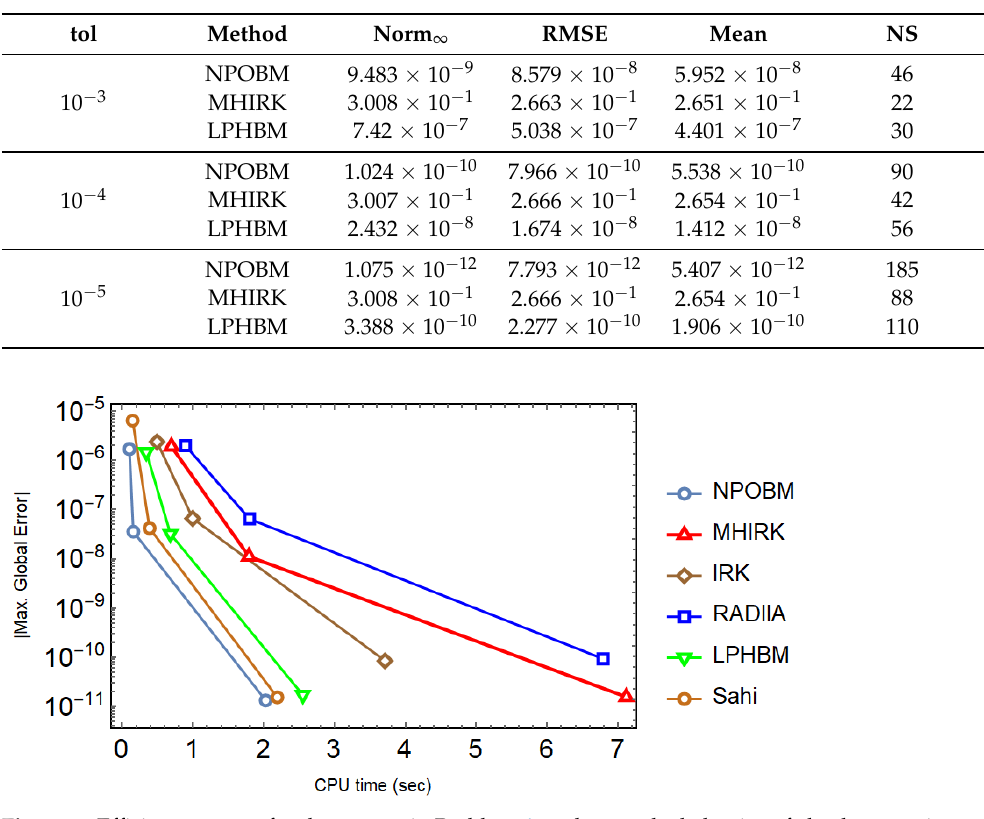
Figure 9. Efficiency curves for the system in Problem 4 to observe the behavior of absolute maximum global errors versus the CPU time (sec) with a logarithmic scale on y -axis.